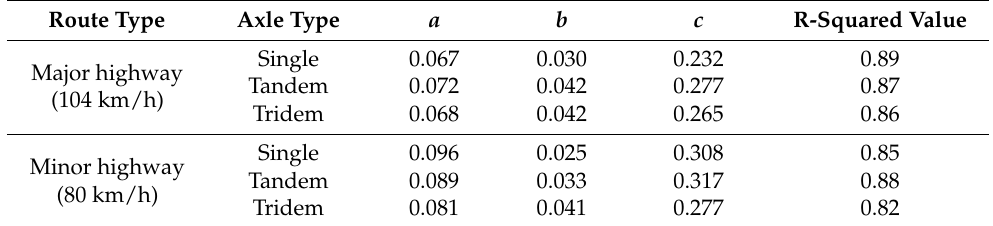
Table 1. Parameters of regression model of DLC with respect to IRI and axle load. Route